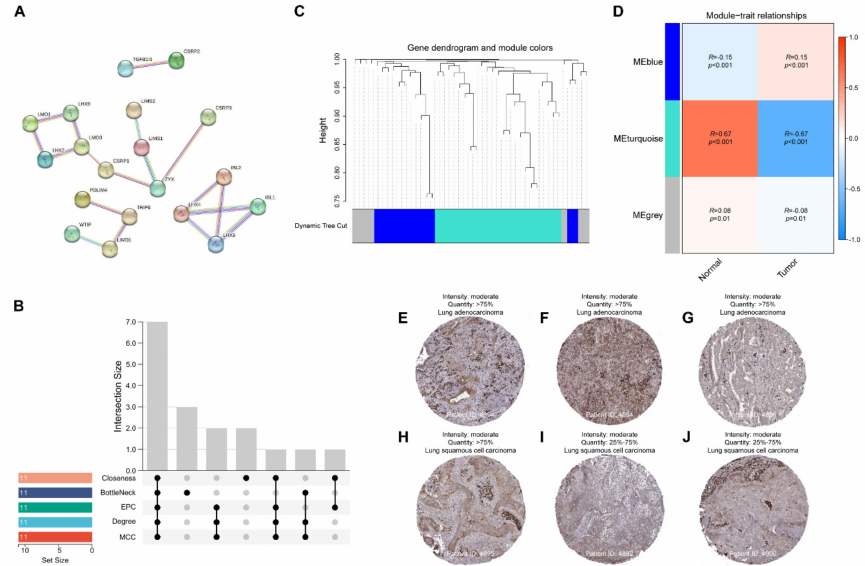
Figure 6. Hub genes screened with five algorithms from cytoHubba and the weighted gene co- expression network analysis. ( A ) Protein–protein interaction network diagram of the LIM domain family genes. ( B ) The Venn diagram revealed that five algorithms screened seven overlapping hub LIM domain family genes. ( C ) Three modules were identified based on the hierarchical clustering dendrogram of 47 LIM domain family genes. ( D ) Heatmap of the correlations between MEs and the trait for the tumor and normal lungs. The MEblue module was significantly positively correlated with clinical traits in the tumor, while the MEturquoise module was significantly positively associated with clinical traits in healthy lungs. ( E – J ) Representative immunohistochemistry images of LIM and senescent cell antigen-like domain 1 (LIMS1) across clinical specimens of non-small-cell lung cancer samples in the HPA database.